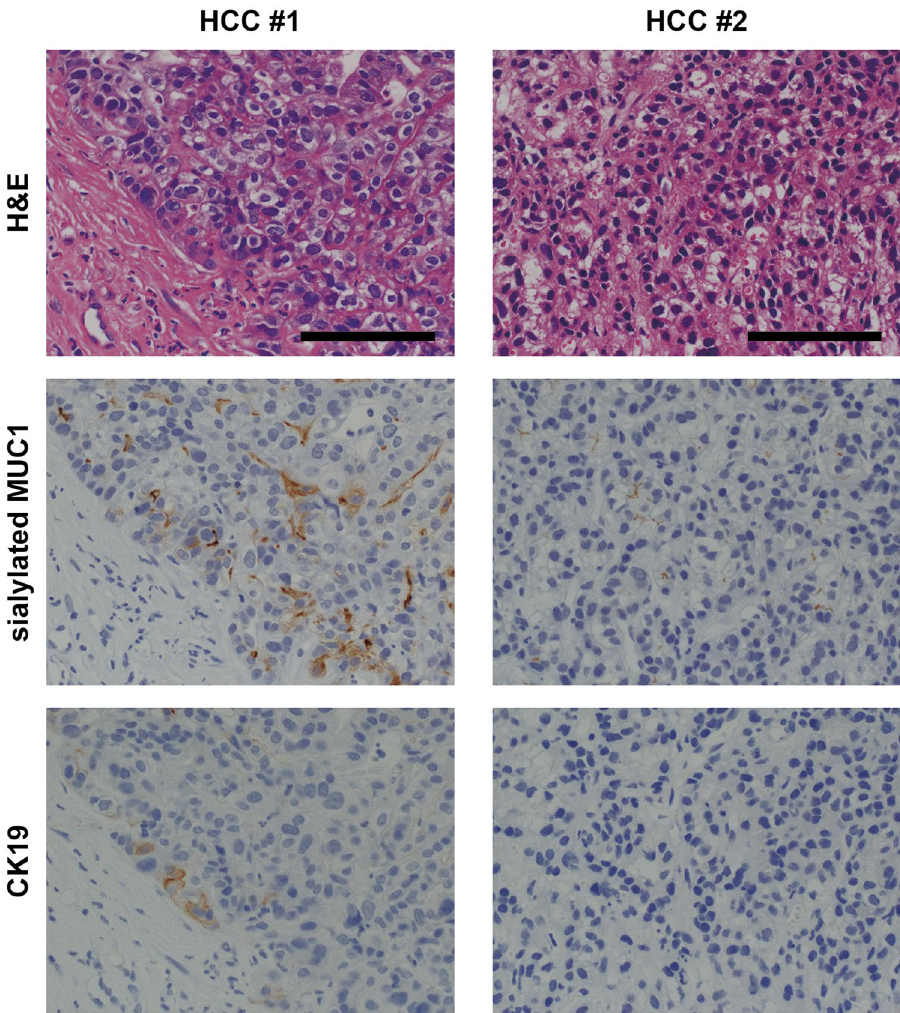
Figure 1. Representative staining for sialylated MUC1 and CK19 in liver biopsies. Liver biopsies (HCCs #1 and #2) were stained with hematoxylin–eosin (H&E) and antibodies against sialylated MUC1 and CK19. It was regarded as sialylated MUC1-positive in HCCs #1 and #2, while CK19-positive in HCC #1 and –negative in HCC #2. Scale bar = 100 µ